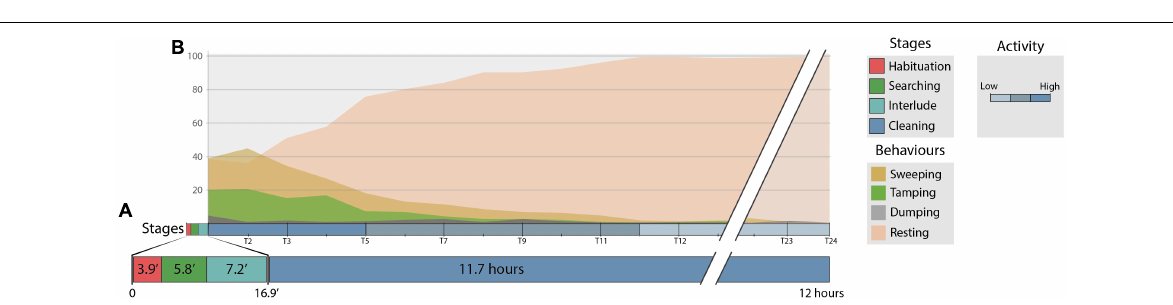
FIGURE 7 | (A) Mean duration (minutes) of the habituation, searching, interlude and cleaning stages of den cleaning behaviour displayed by snapping shrimps during observation experiments under controlled laboratory conditions. (B) Relative frequency of four behaviours (sweeping, tamping, dumping and resting) exhibited by snapping shrimps during the cleaning stage. T 1 − 24 represent the 30-min intervals throughout the 12-h observation period. Shades of blue indicate high, medium and low cleaning activity as the relative frequency of resting increased. Calculations were made for n = 12 independent